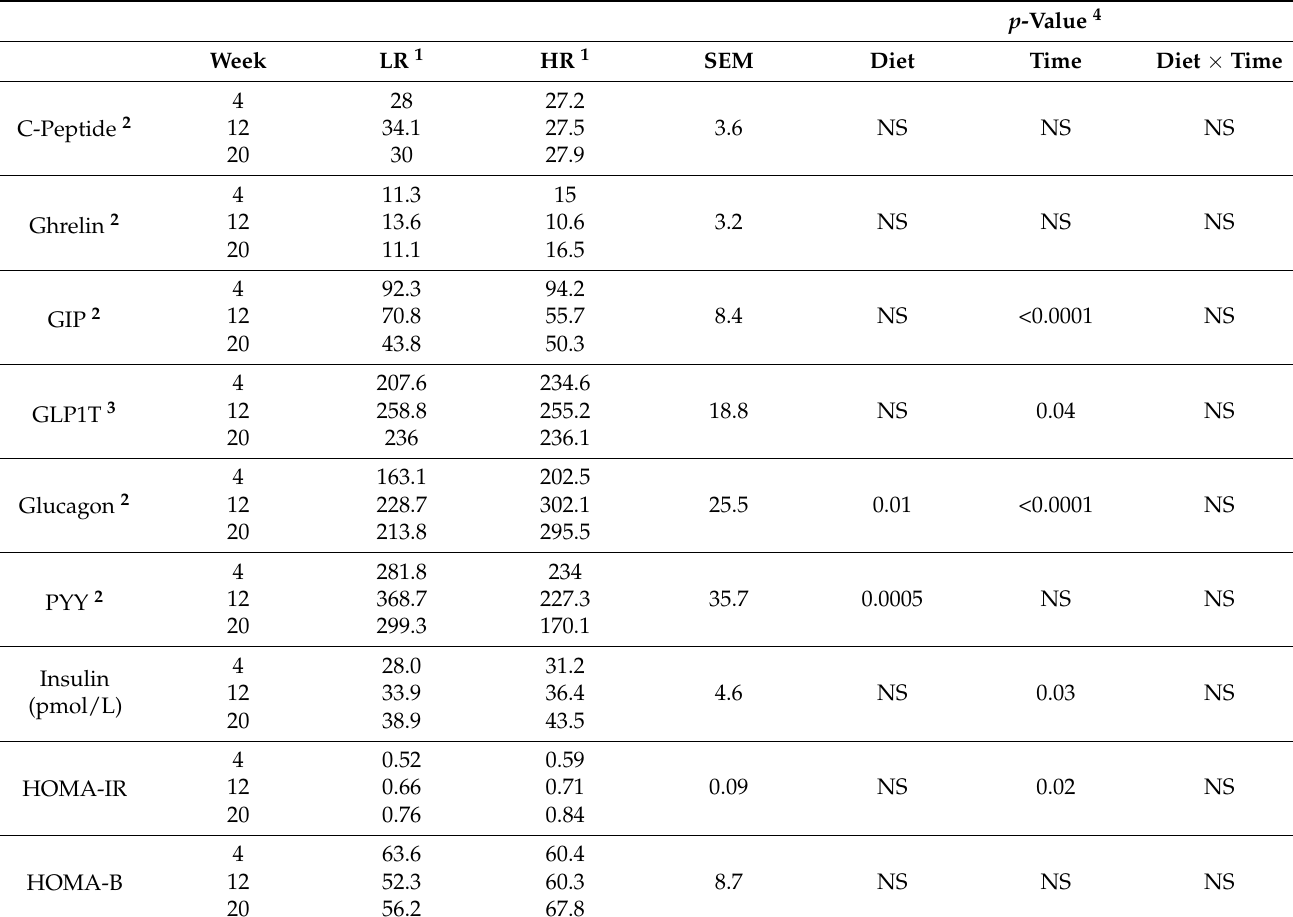
Table 4. Plasma concentrations of circulating